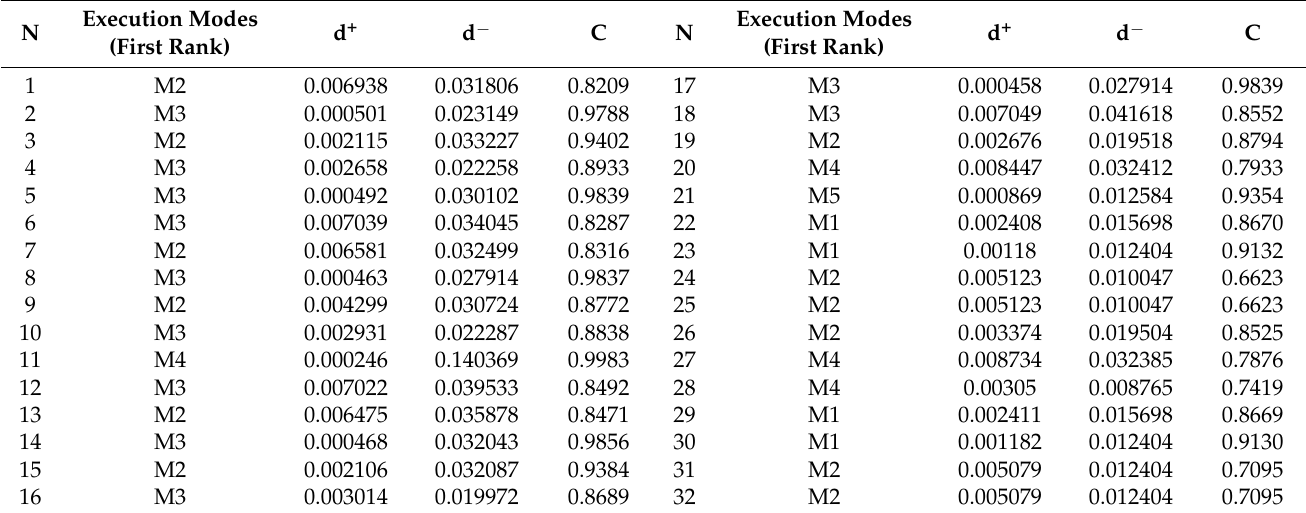
Table 6. Results of fuzzy TOPSIS (project by 32